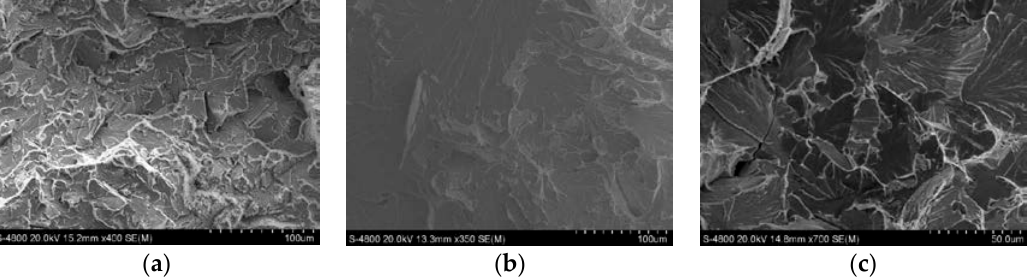
Figure 4. Sample of micro-fracture ( − 40 °C): ( a ), impact fracture of 16 mm thickness plate; ( b ), impact fracture of 25 mm thickness plate; ( c ), impact fracture of 40 mm thickness plate.